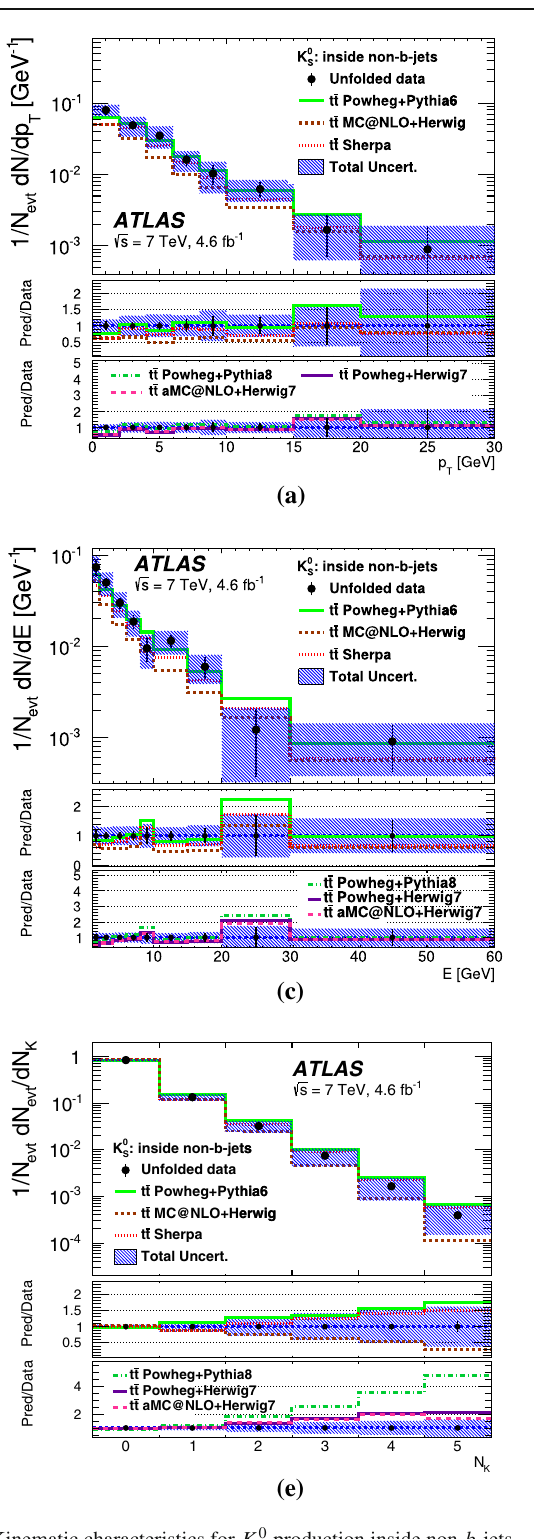
Pythia8 , Powheg + Herwig7 generators. Total uncertainties are rep- Fig. 9 Kinematic characteristics for K 0 production inside non- b -jets, S for corrected data and particle-level MC events simulated with the resented by the shaded area. Statistical uncertainties for MC samples Powheg + Pythia6 , MC@NLO + Herwig , Sherpa , Powheg + are negligible in comparison with